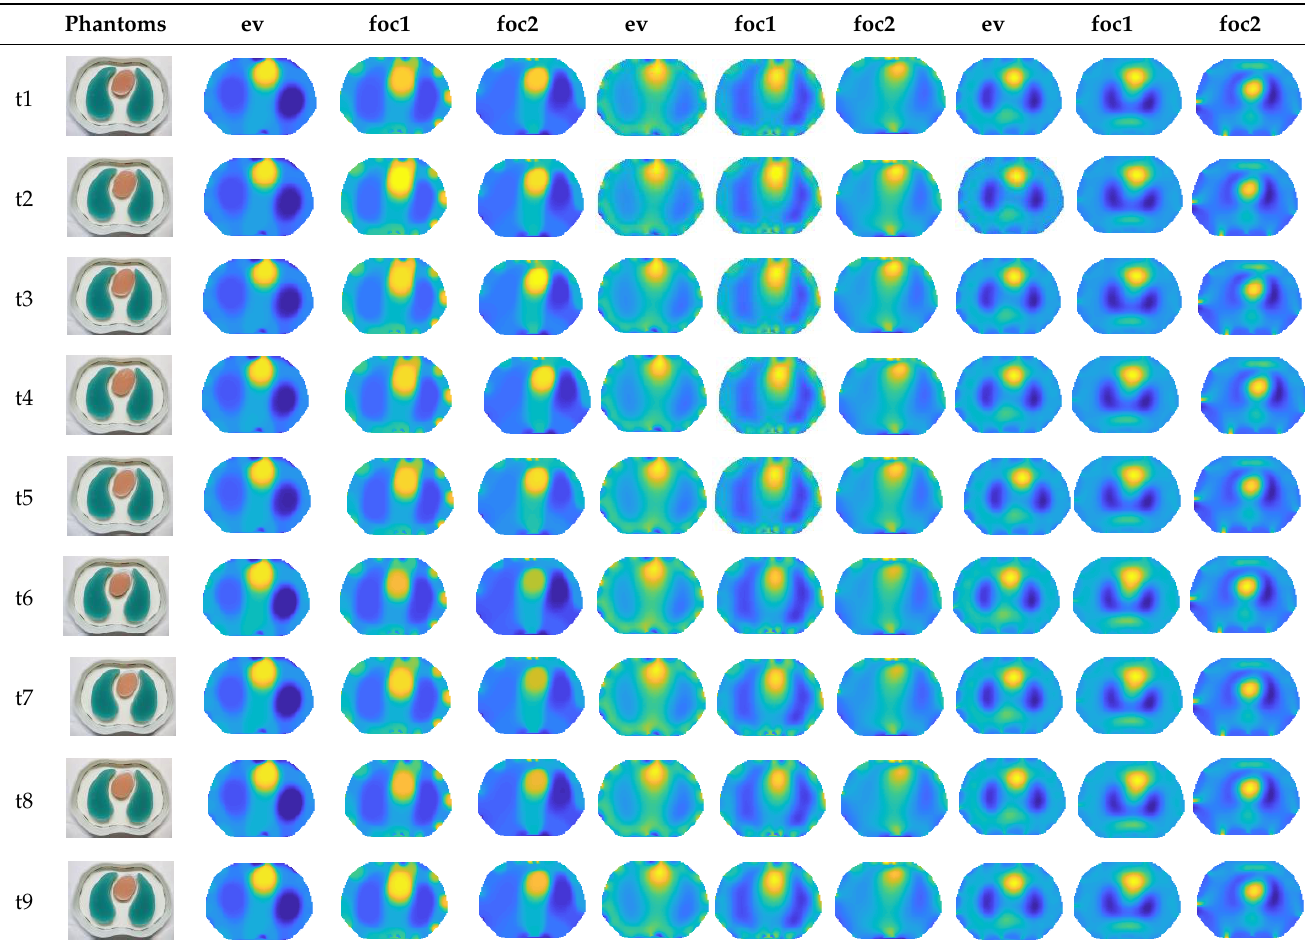
Table 3. Image reconstruction results from proposed optimized sensor and uniform sensor under different algorithms.